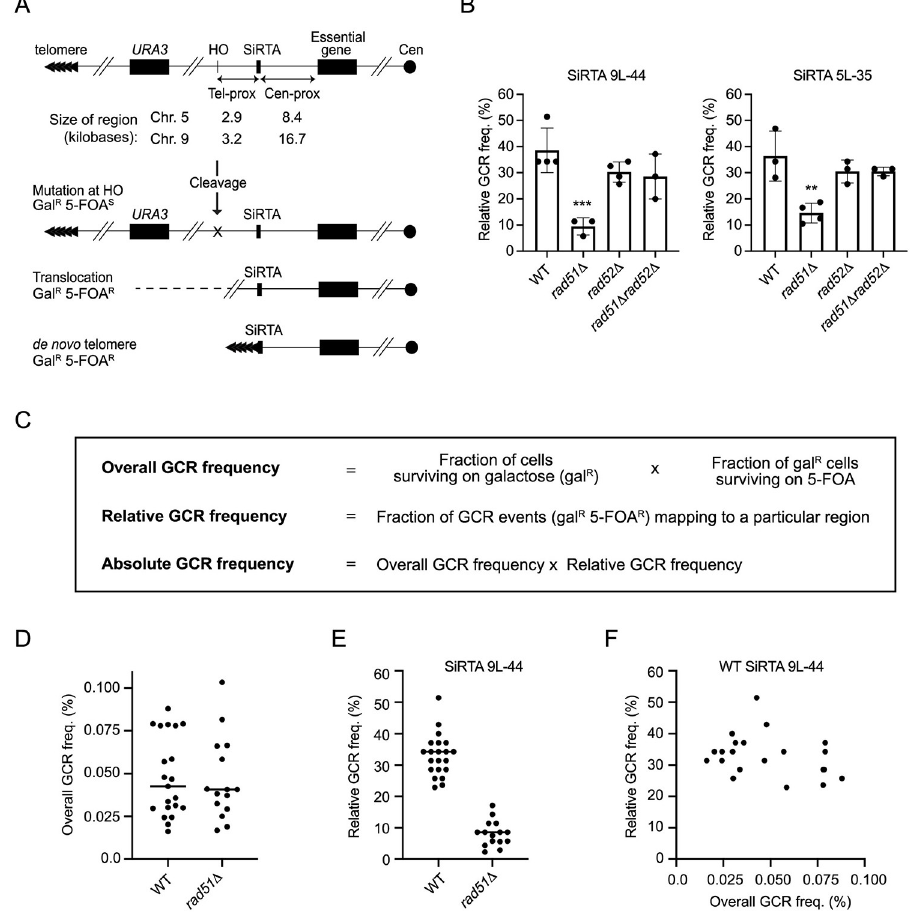
Fig 1. Rad51 promotes de novo telomere addition at SiRTAs 9L-44 and 5L-35 by inhibiting Rad52 function. (A) Schematic of the HO cleavage assay system. MCM10 and PCM1 are the most distal essential genes on the left arms of chromosome 9 and 5, respectively. Cleavage is induced by the expression of HO endonuclease upon plating on galactose-containing medium, surviving colonies lacking URA3 function are selected on media containing 5-FOA, and the approximate location of each GCR event is mapped by PCR to the SiRTA, the region centromere-proximal to the SiRTA (Cen-prox), or the region telomere-proximal to the SiRTA (Tel-prox). The sizes in kilobases of each of these regions are shown for the SiRTAs on chromosomes 5 and 9. (B) The relative GCR frequency within the indicated SiRTA is shown for WT and mutant strains. Averages from at least three independent experiments are shown with standard deviations. Strains statistically different from WT by ANOVA with Dunnett’s multiple comparisons test are indicated by asterisks ( �� p < 0.01; ��� p < 0.001). (C) Definitions and methods for calculating the overall, relative, and absolute frequencies of GCR formation. (D) Overall GCR frequency (%) determined in multiple independent experiments in the RAD51 (WT) and rad51 Δ strains after HO cleavage on chromosome 9. Sample numbers are 21 for WT and 15 for rad51 Δ . (E) Relative GCR frequency in SiRTA 9L-44 from the same experiments shown in D. p < 0.0001 by Student’s t test. (F) Plot of overall GCR frequency versus relative GCR frequency in SiRTA 9L-44 for the WT experiments shown in D and